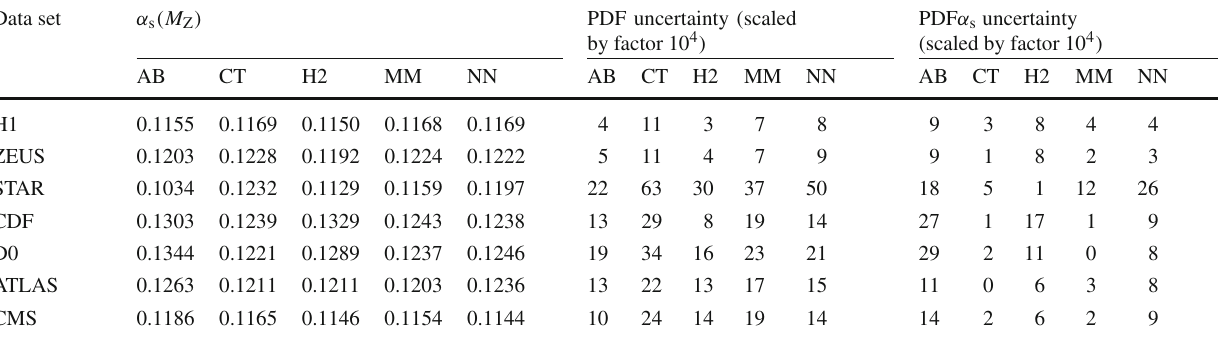
Table 6 Results of common-type fits to single inclusive jet data sets for varying PDF sets. Listed are the α s ( M Z ) results and the respective PDF and PDF α s uncertainty. For the purpose of a more compact presenta- tion,theemployedPDFsetsABMP16(AB),CT14(CT),HERAPDF2.0